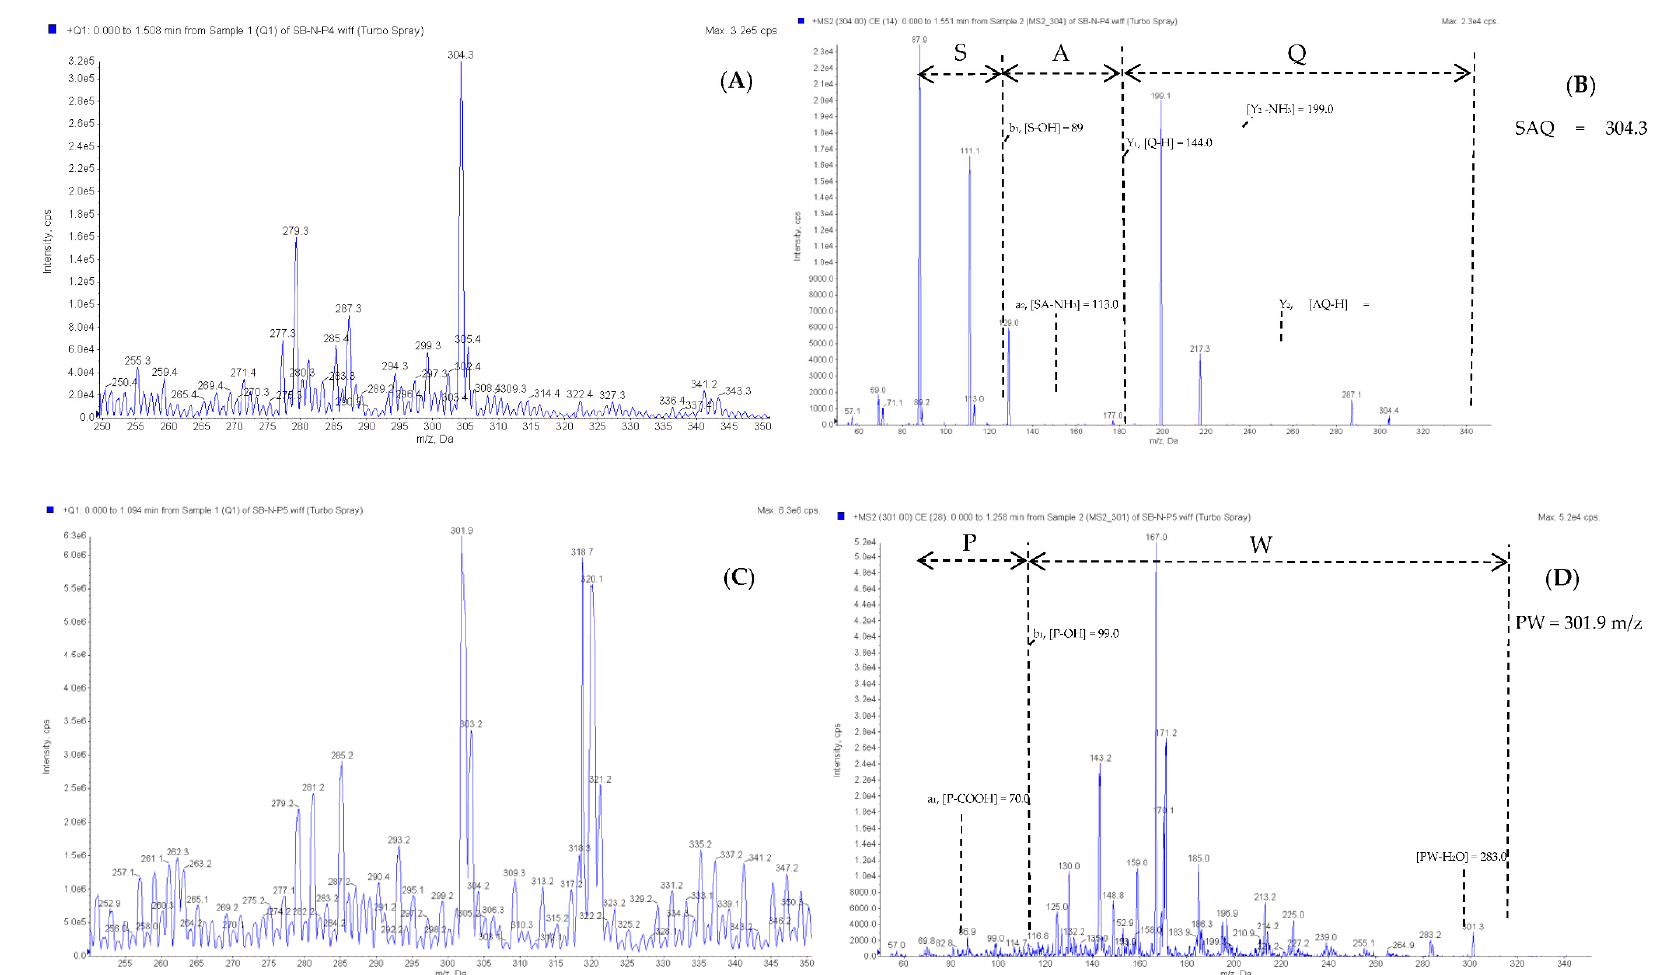
Figure A1. Identification of molecular mass and amino acid sequence of the peak E4 and E5 from F-HHP + PN6-PP by ESI/MS/MS. ( A , B ) the MS/MS spectra of peptide SAQ ( m / z 304.3). ( C , D ) the MS/MS spectra of peptide PW ( m / z 301.9).